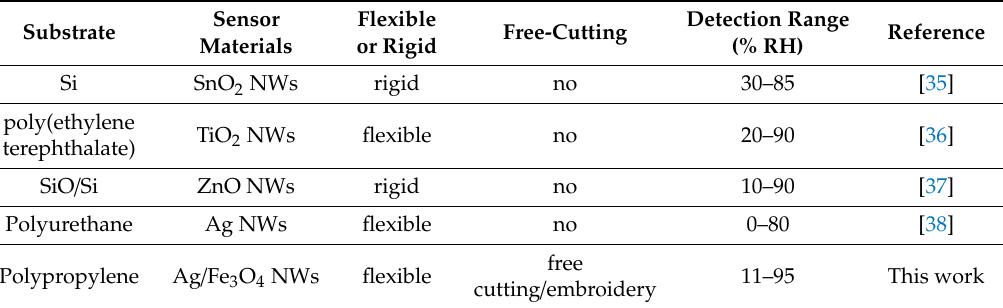
Table 1. Comparison of the Typical Parameters of Di ff erent humidity